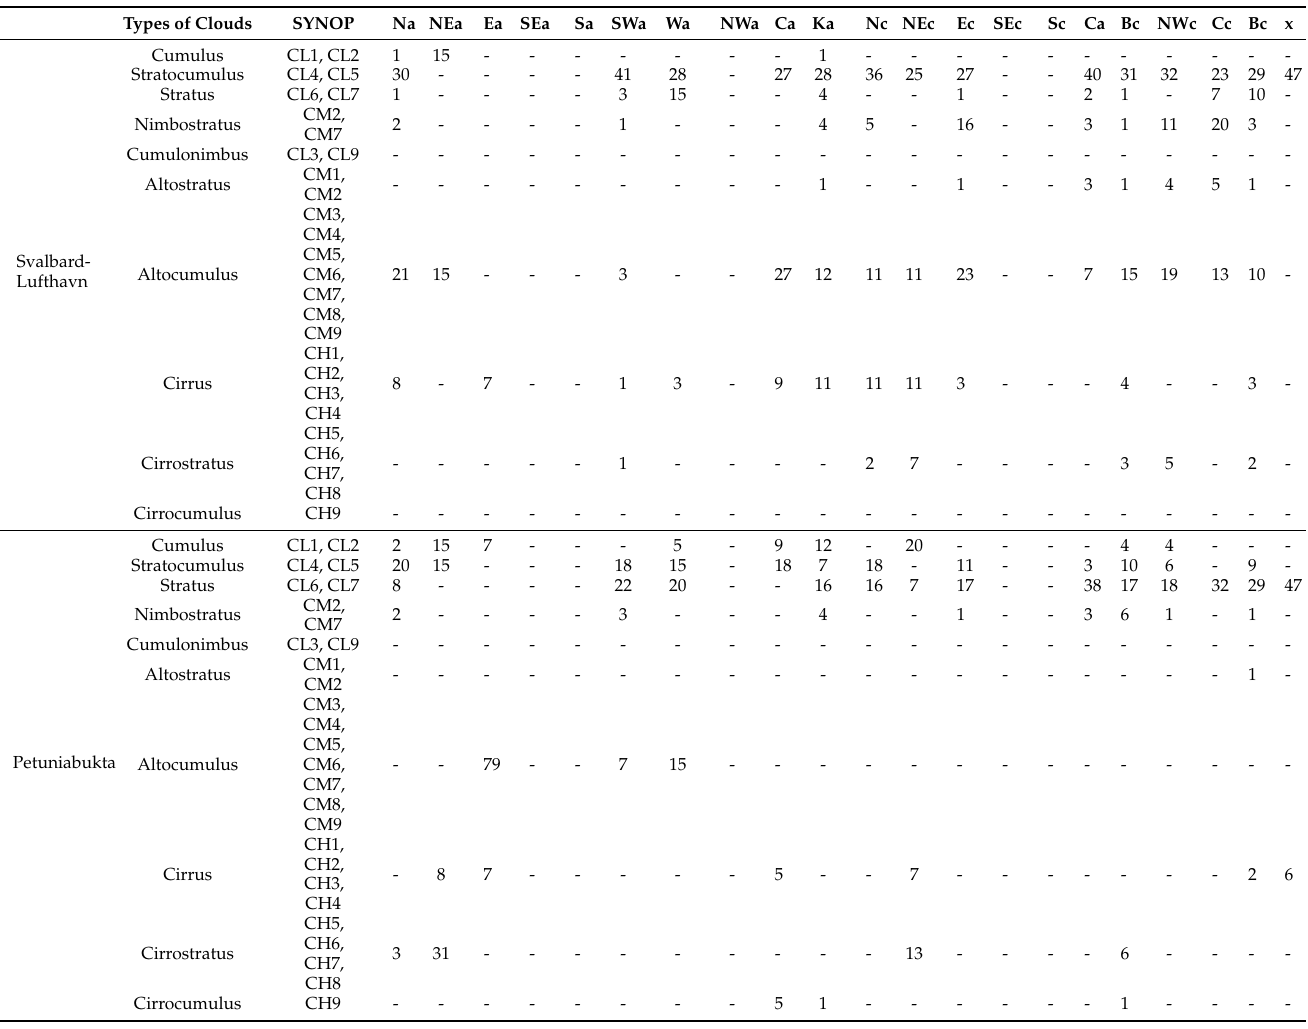
Table 5. The relative frequency (%) of occurrence of cloud types in atmospheric circulation types according to [23] in Svalbard-Lufthavn and Petuniabukta during the period from 9 July to 30 August